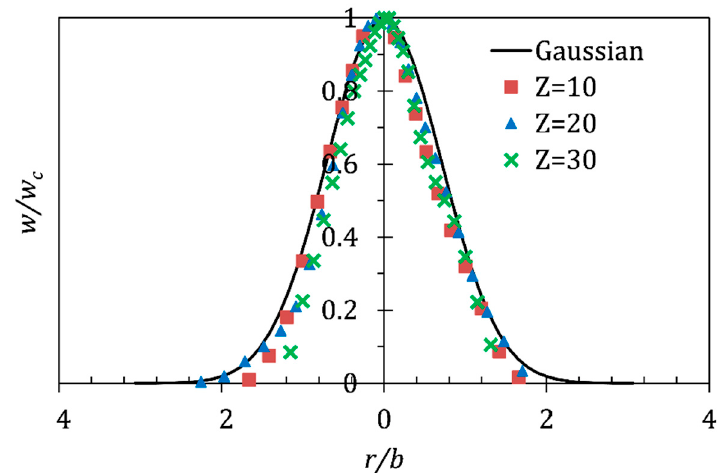
Figure 9. Gaussian and simulated velocity profile of the jet on the horizontal plane.